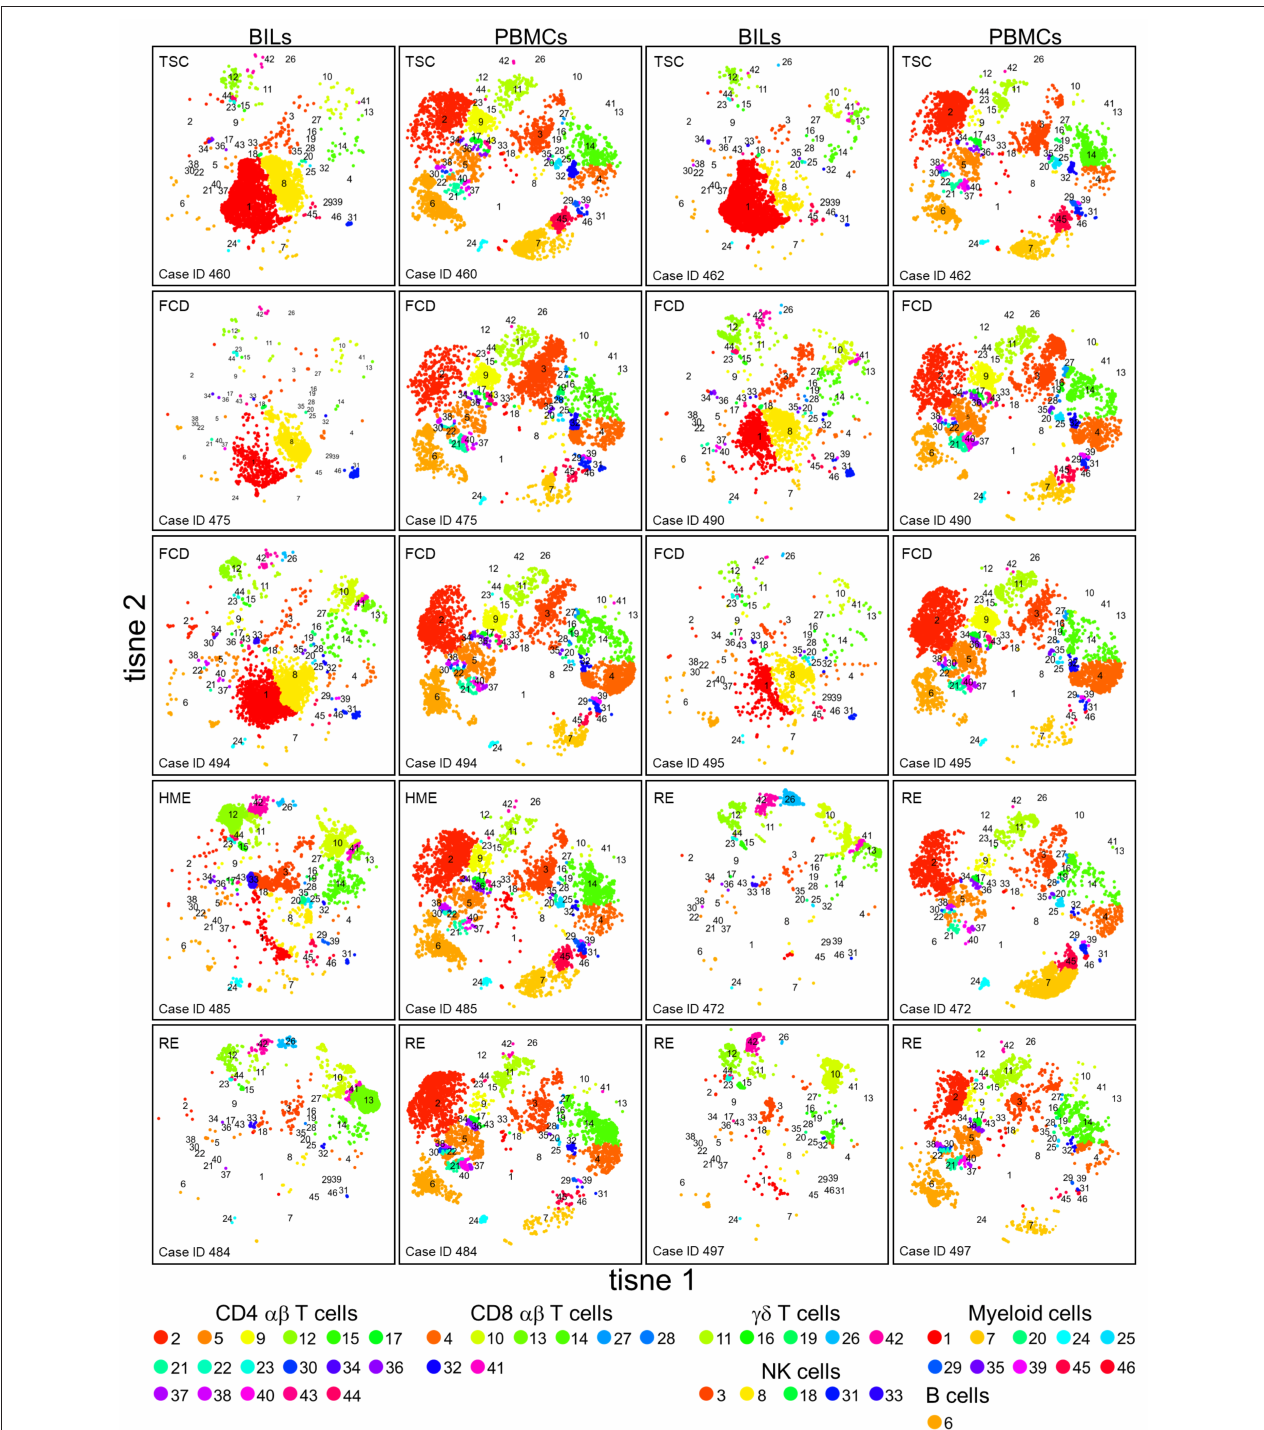
FIGURE 1 | tSNE plots showing the relative number of different immune cells in BILs and PBMCs from the pediatric epilepsy surgeries. The expression of 20 immune cell markers was analyzed by CyTOF. To define subsets of CD45 + cells in each BIL and PBMC population, the entire high dimensional dataset (comprising 20 FCS files) was converted into a matrix of pair-wise similarities by implementing the t-based stochastic neighbor embedding (t-SNE) algorithm, followed by a density-based clustering method (ClusterX). The clusters were assigned as either T cells, NK cells, myeloid cells, or B cells based on the median expression values of specific immune cell markers (CD3, CD4, CD8, TCR γδ , CD11b, CD56, and CD19).